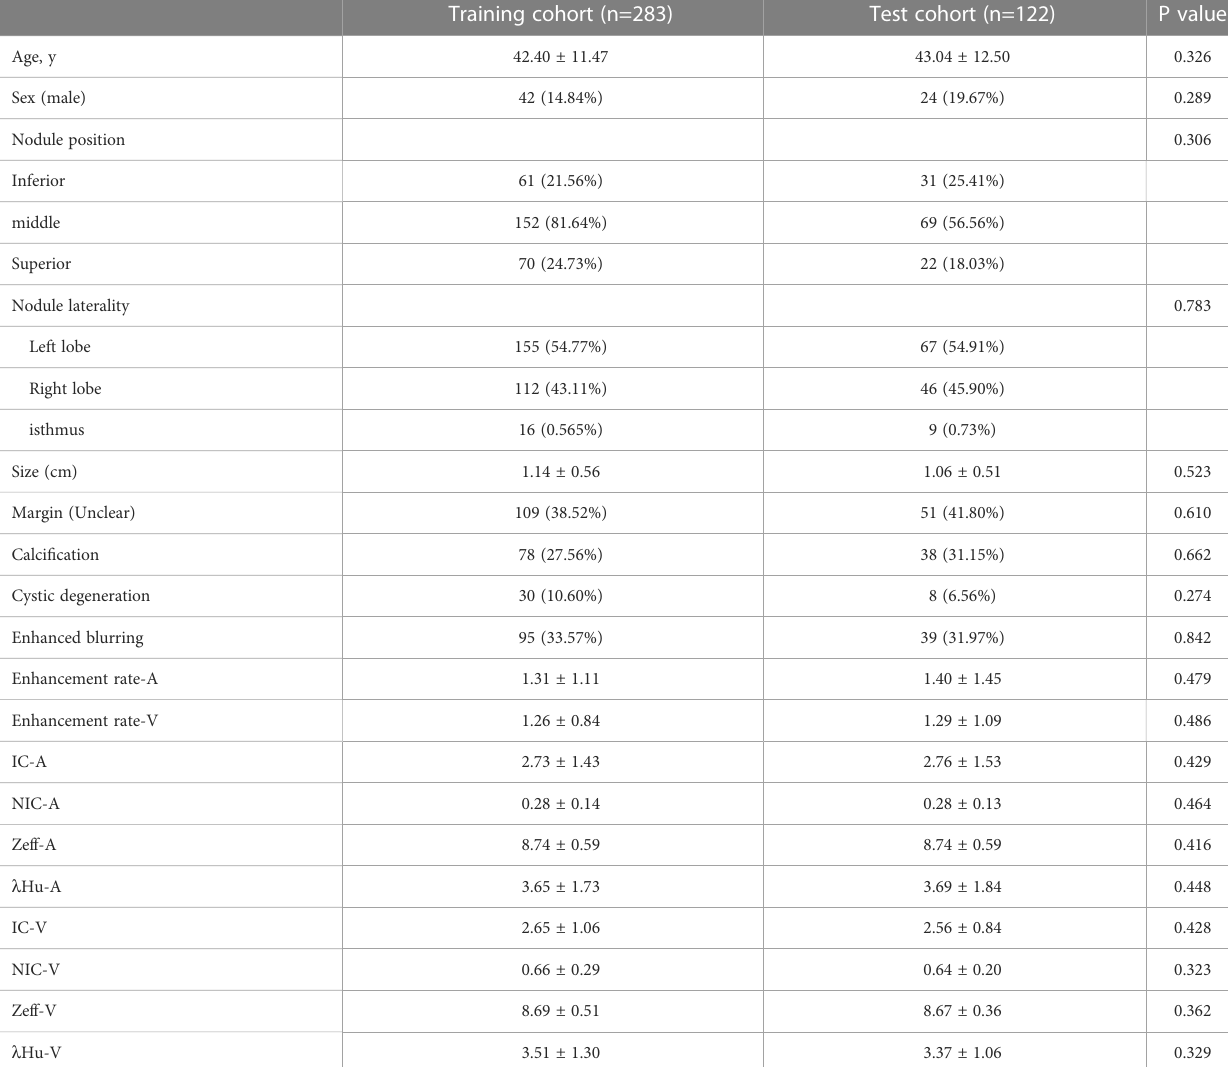
TABLE 1 Clinical Characteristics and DLCT Parameters of Patients in Training and Test